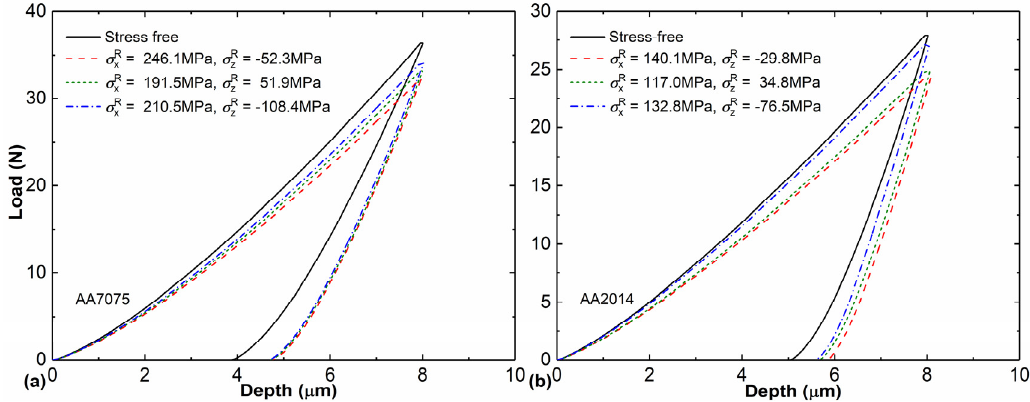
Figure 9. The average load-depth curves for spherical indentations on (a) AA 7075 and (b) AA 2014 with various residual stresses. Table 2. The average plastic parameters, indentation characteristic parameters, and applied and calculated stresses for AA 7075 and AA